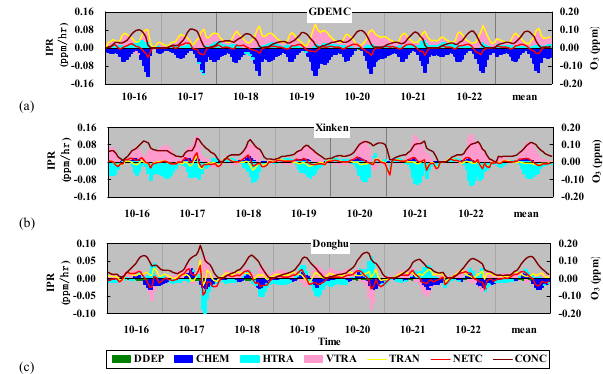
Fig. 8. Daily variations of O 3 concentration and hourly O 3 change rates due to various atmospheric processes in the lowest three layers (0–80ma.g.l.) at (a) GDEMC, (b) Xinken, and (c) Donghu from 16–22 October 2004. (VTRA: vertical transport, the net effect of vertical advection and diffusion; HTRA: horizontal transport, the net effect of horizontal advection and diffusion; TRAN: transport, the net effect of VTRA and HTRA; DDEP: dry deposition; CHEM: gas-phase chemistry; NETC: the net change of hourly O 3 due to all atmospheric processes; CONC: instantaneous O 3 concentration at the end of each